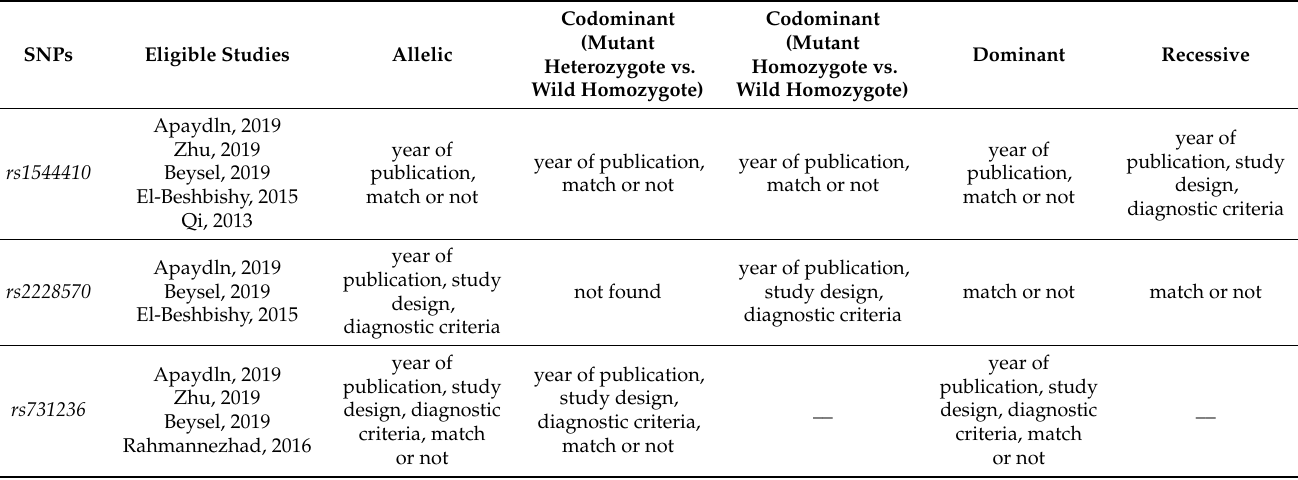
Table 3. The sources of